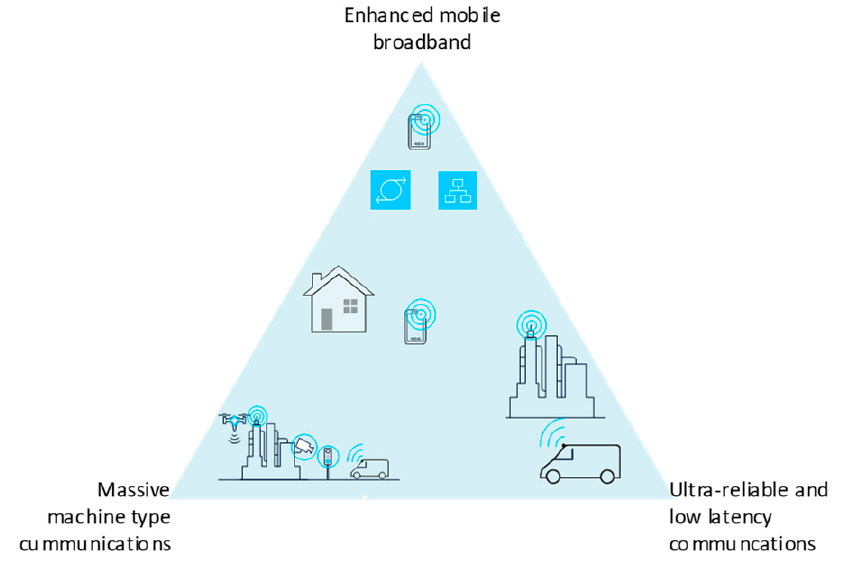
Figure 1. Usage scenarios for 5G and beyond [3].